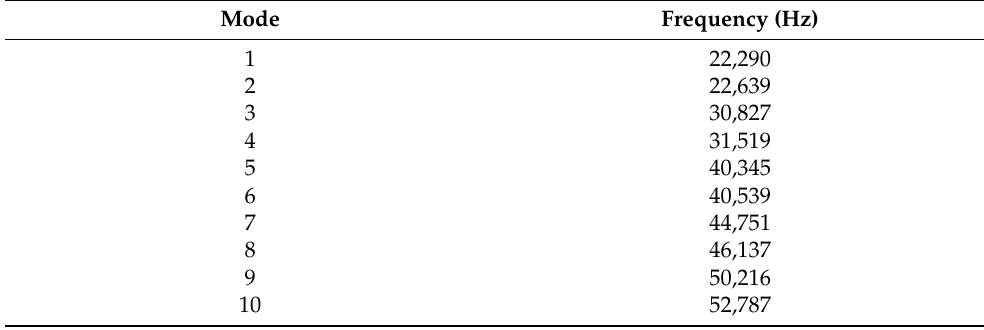
Table 5. The first 10 modal (natural) frequencies of the pair of two larger PIN24%-PMN-PT and PMN-24% PT